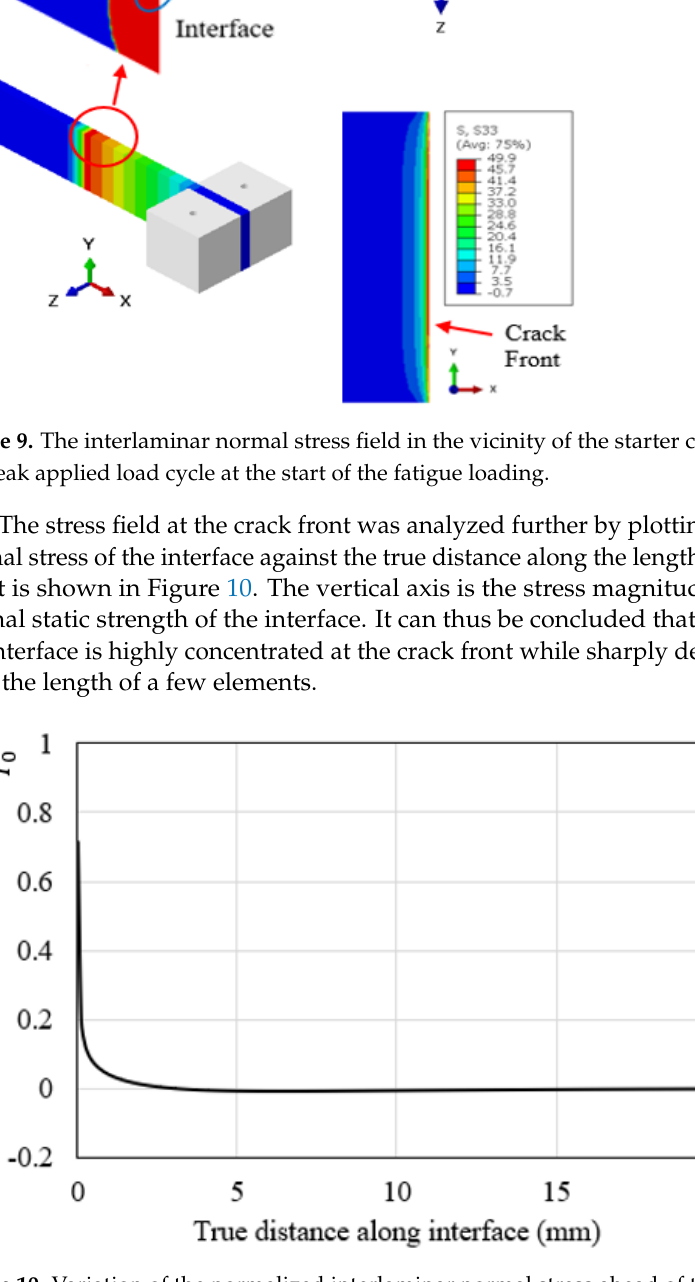
Figure 10. Variation of the normalized interlaminar normal stress ahead of the starter crack front at the start of the fatigue cycles.